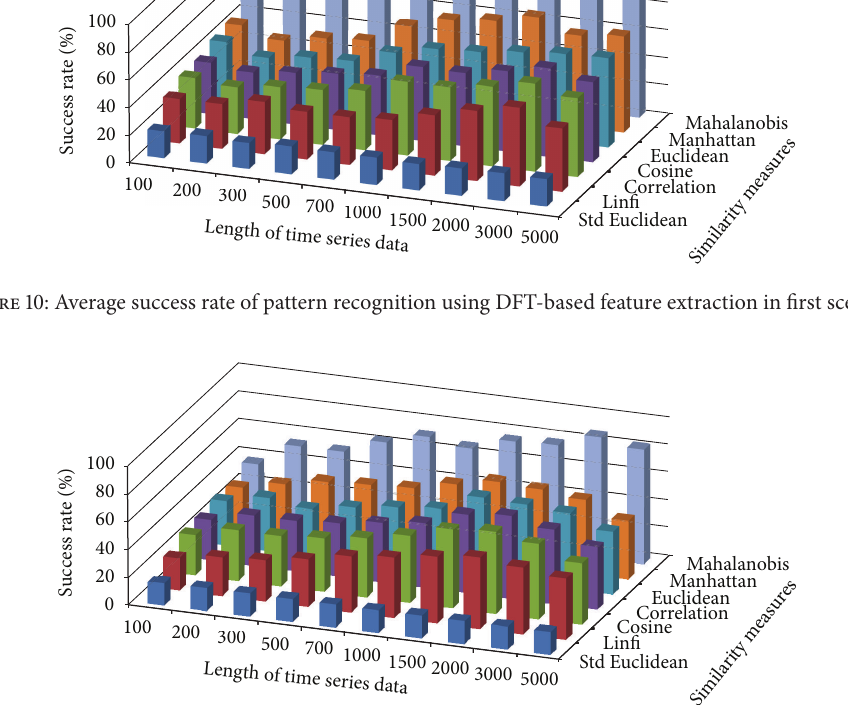
Figure 11: Average success rate of pattern recognition using DFT-based feature extraction in second scenario.